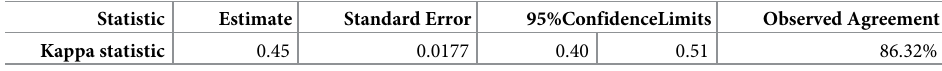
Table 3. Agreement among mothers’ perception of size at birth (small vs average or above average) and birth weight ( < 2500 grams vs. � 2500 grams); NDHS 2016.